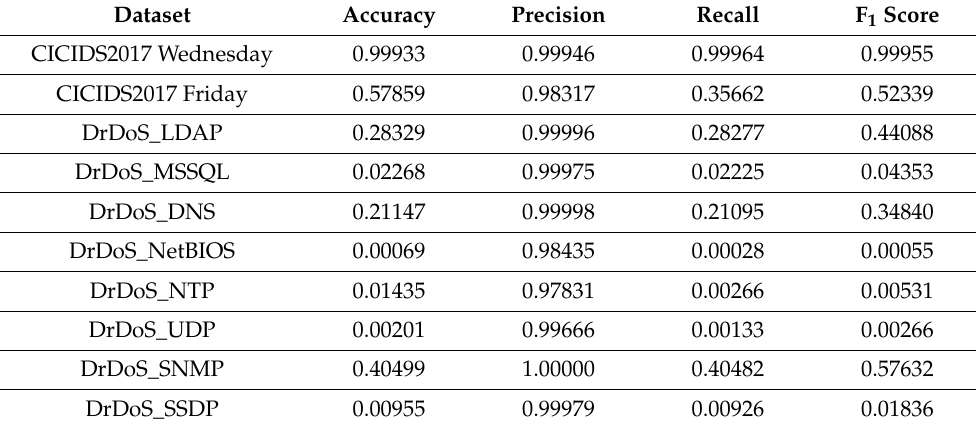
Table 7. Model’s detecting results on each